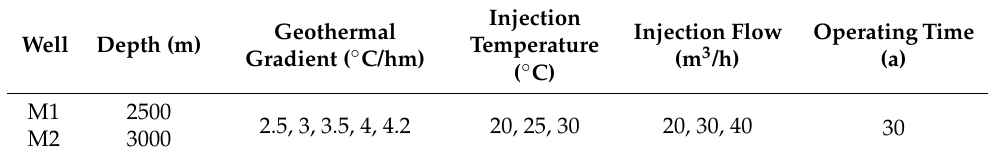
Table 2. Numerical simulation